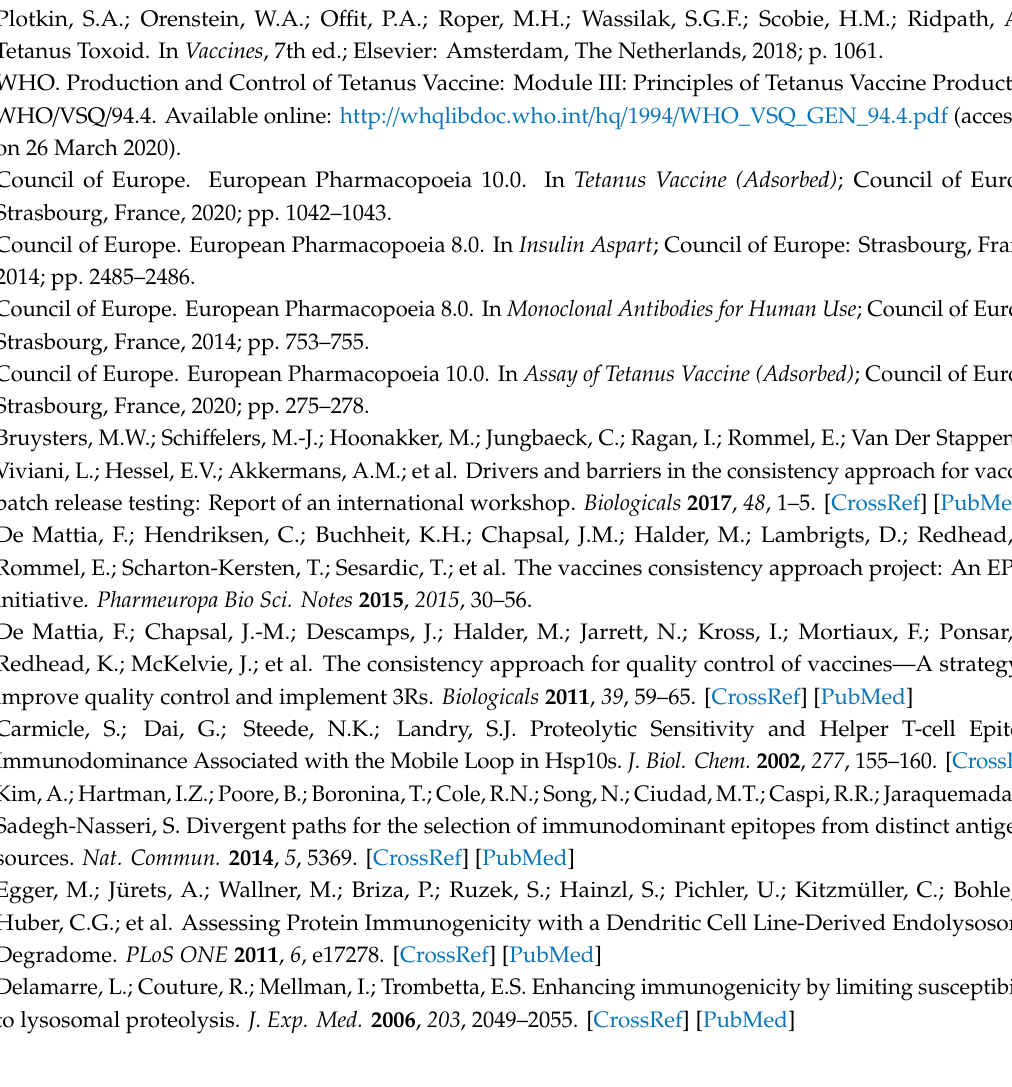
Figure S1: Crystal structure of tetanus toxin where the selected peptides that were formed faster from cathepsin S digestion after temperature exposure are highlighted, Figure S2: Representative chromatogram and spectra of the tetanus toxoid degradomics analysis., Figure S3: Representative size exclusion chromatography chromatogram of TTd-B1.1 after exposure to 4, 37, 45, 50, 55, 60, or 65 ◦ C for two days. Table S1 contains the exported PEAKS